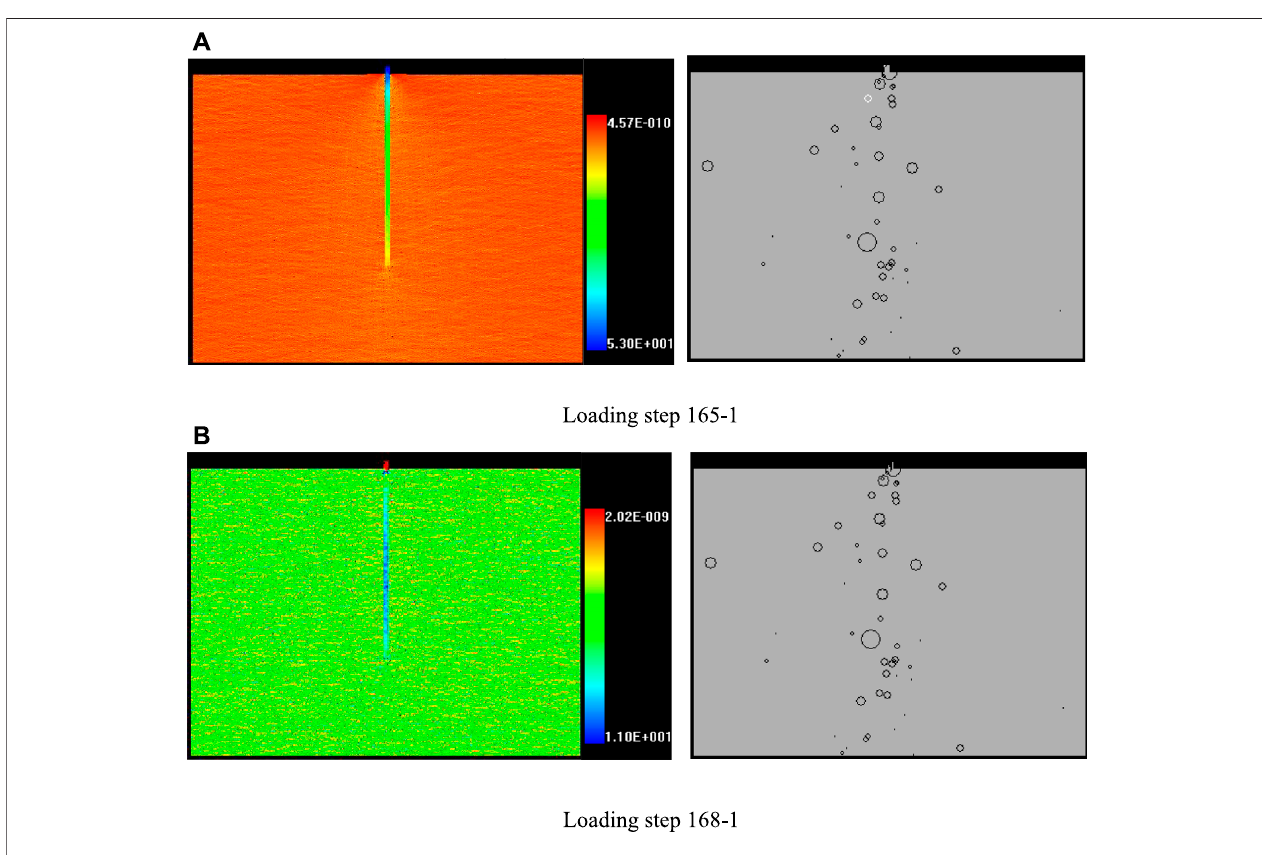
FIGURE9| FailureprocessofanchoredrockwiththepositivePoisson ’ sratiobolt(theleftcolumnistheminimumprincipalstressnephogram,andtherightcolumn is the acoustic emission diagram). (A) Loading step 165-1. (B) Loading step 168-1.